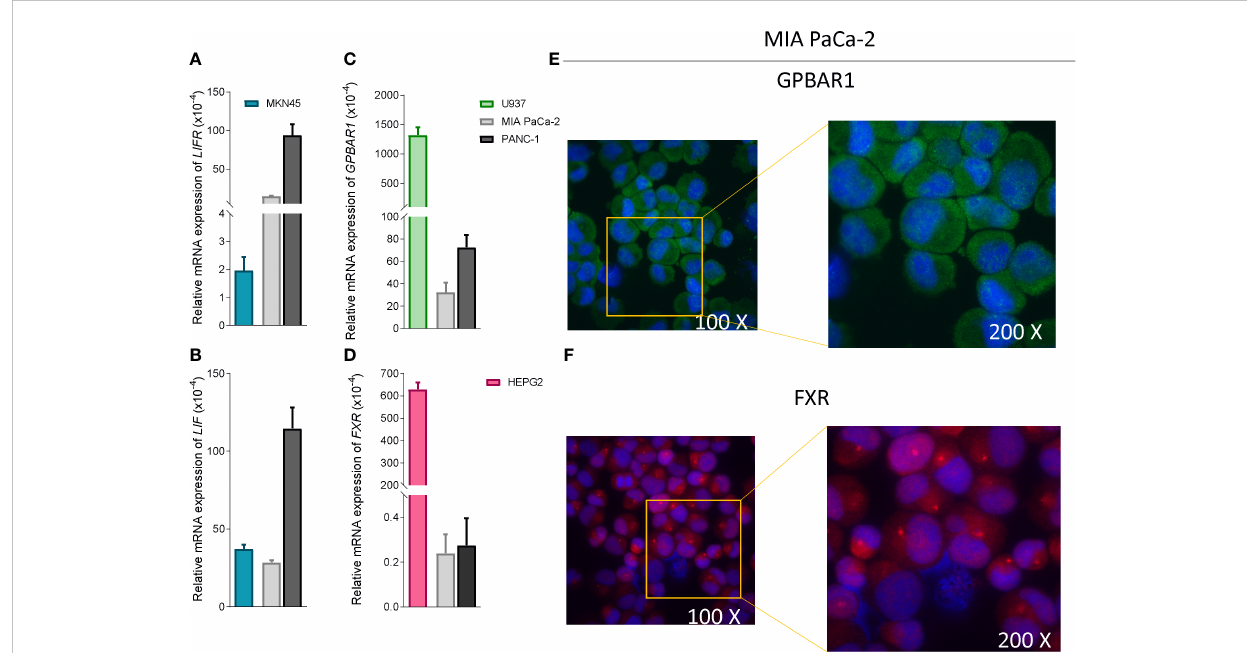
FIGURE 4 PDAC cells expressed low levels of bile acids receptors. Relative mRNA expression of (A) LIFR (B) LIF compared to MKN45 (C) GPBAR1 compared to U937 and (D) FXR compared to HEPG2. Each value is normalized to GAPDH and is expressed relative to those of positive controls, which are arbitrarily set to 1. Results are the mean ± SEM of three samples for group. Immuno fl uorescence analysis of (E) Gpbar1 and (F) Fxr in MIA PaCa-2 cells (Magni fi cation 100x on left and 200x on